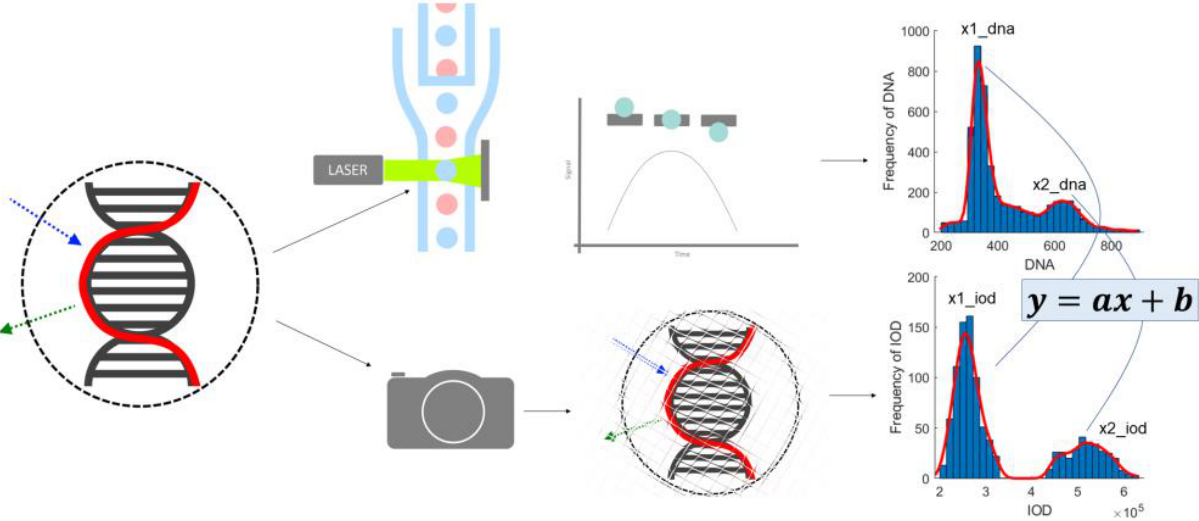
Figure 11. Overview of the reference (FCM) and the proposed (ICM) methods: The two approaches attempt to measure the same physical property through two different appliances. The ICM method was shown to have a linear response to uniform-intensity sources (i.e., fluorescent beads) with the parameter of exposure time (within the detection range of the appliance). Measuring nuclei, the same method is proposed to also have a linear relationship with the values produced by the reference method.